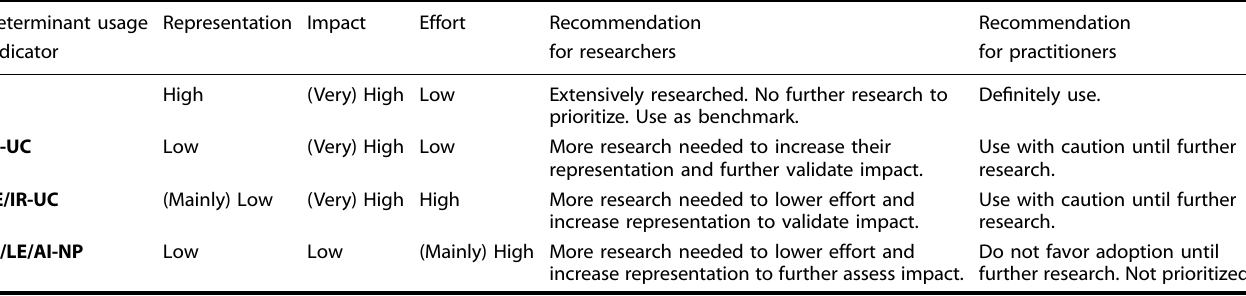
Table 5. Framework for trade-off analysis, based on representation, impact, and